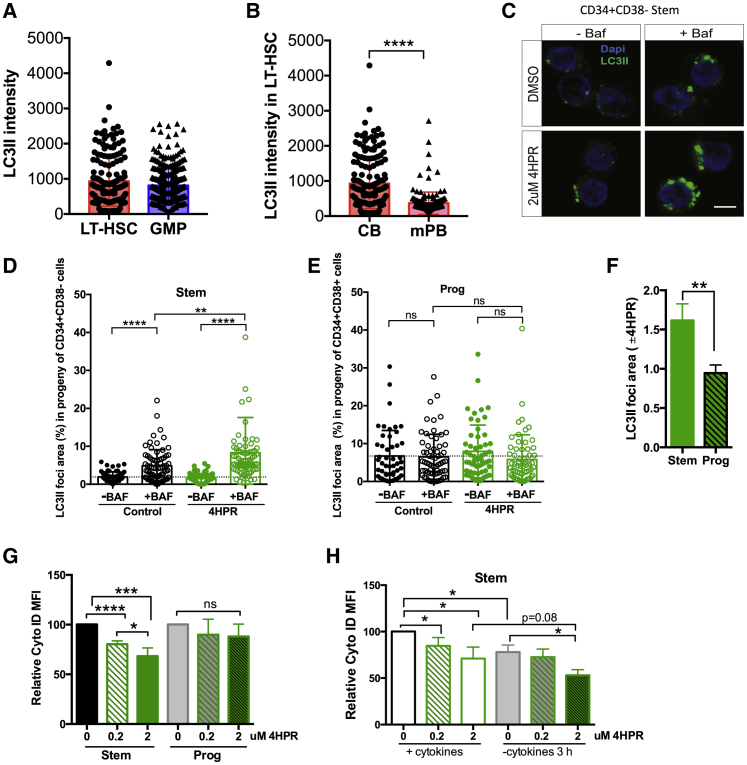
4HPR Activates Autophagy in HSPCs during Ex Vivo Culture(A and B) LC3II staining intensity of (A) LT-HSCs (174 cells) and GMPs (312 cells) isolated from CB (n = 3) or (B) mPB (165 cells; n = 3 mPB) LT-HSCs compared to CB LT-HSCs.(C) Representative microscopy images of DAPI (blue) and LC3II staining (green) for (C) CD34+CD38− (stem) cells following 2 days of treatment with DMSO control or 2 μM 4HPR and ±BAF. Scale bar is 5 μm.(D and E) LC3II foci area for (D) stem and (E) prog cells from one of three CB. The mean in control stem cells without BAF is shown with a dotted line.(F) Relative LC3II foci in the presence of BAF for stem and Prog populations.(G) Relative Cyto-ID flux for 0 (DMSO), 0.2 μM, and 2 μM 4HPR in stem and prog populations at 2 days post-treatment (n = 4).(H) Relative Cyto-ID MFI measurements for stem-enriched samples to analyze autophagic flux with and without cytokine withdrawal with indicated drug treatments at day 2.∗p < 0.05; ∗∗p < 0.01; ∗∗∗p < 0.001.